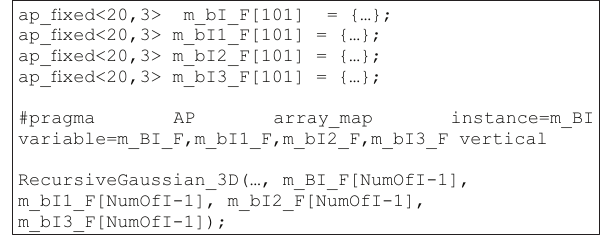
Figure 3: Code Example 1—array map directive to save BRAM use. Figure 4: Code example 2—loop unroll and expression balancing for fine-grained